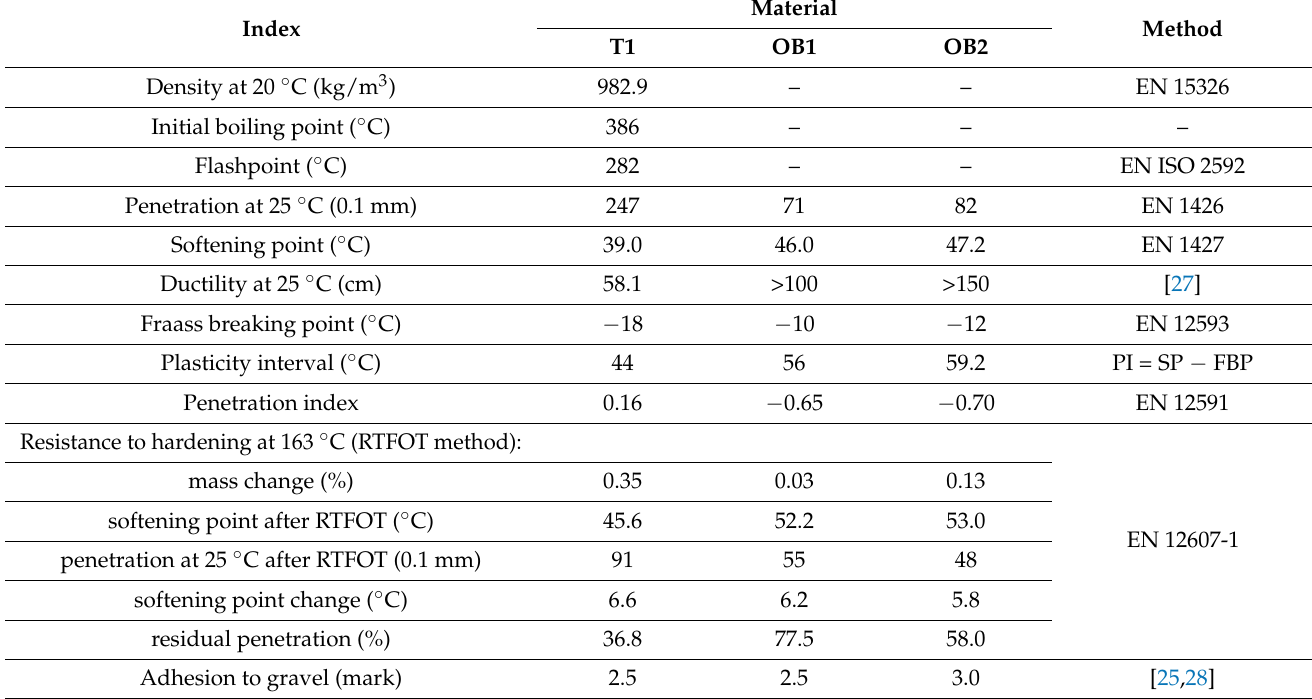
Table 1. Physico–chemical characteristics of raw